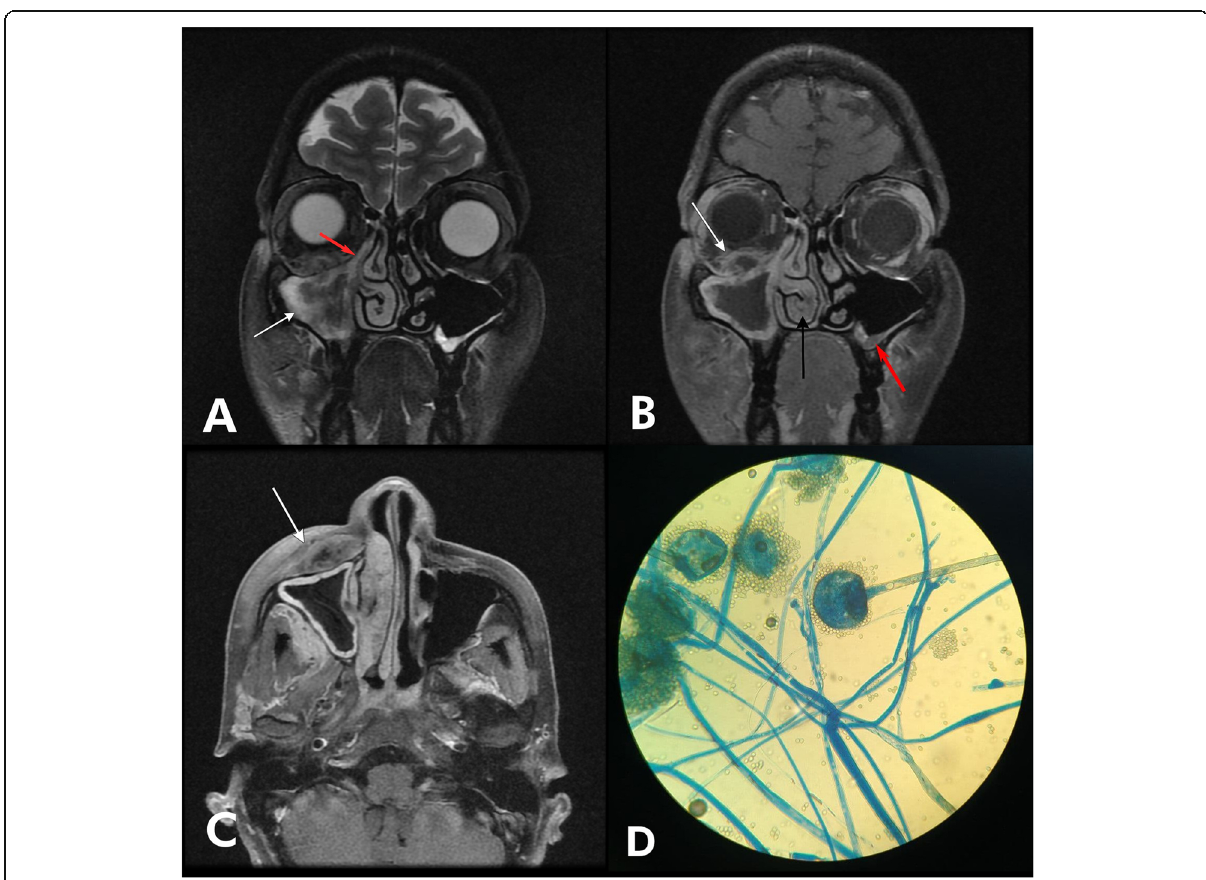
Fig. 3 a Coronal T2 image showing mucosal thickening in right maxillary sinus (white arrow) causing blockage of the right osteomeatal unit (red arrow). b Coronal T1 FS post-contrast image showing extension of inflammation in right inferior orbit (white arrow) with post-contrast peripheral enhancement, right inferior turbinate hypertrophy (black arrow), and left maxillary wall thickening (white arrow). c Axial T1 FS post-contrast image showing right pre-maxillary soft tissue swelling with enhancement (white arrow). d Lactophenol cotton blue (LPCB) stain showing broad ribbon- like fungal hyphae with